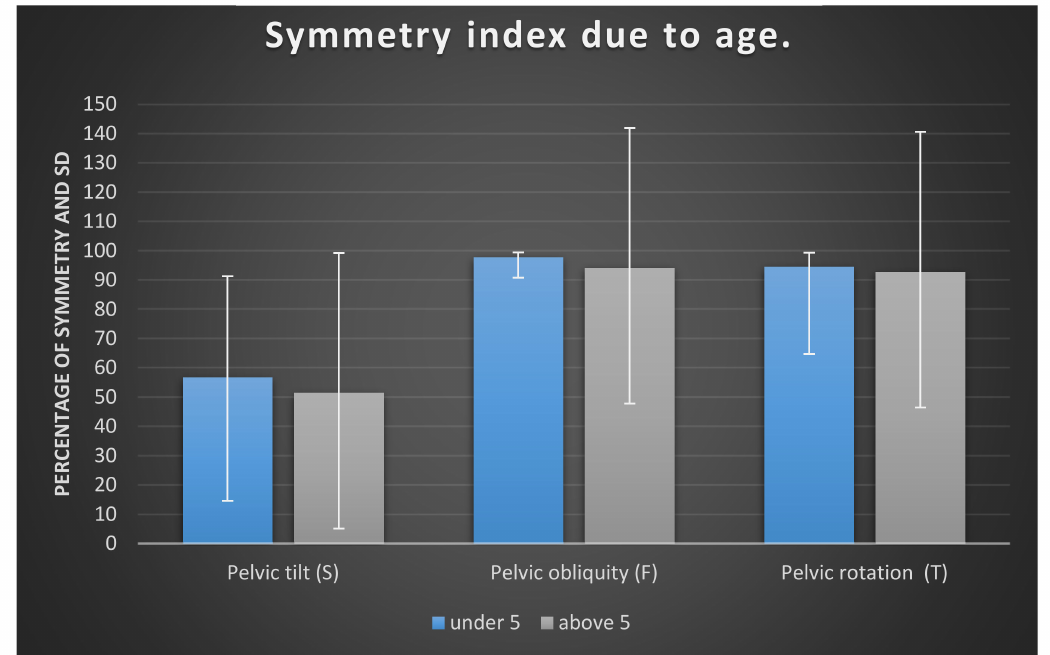
Figure 6. Symmetry index of pelvic tilt, pelvic obliquity, and pelvic rotation in examined children, shown as mean according to age. Table 3. Gait parameters comparison between the two groups of younger and older children. Under 5 Years Old Above 5 Years Symmetry